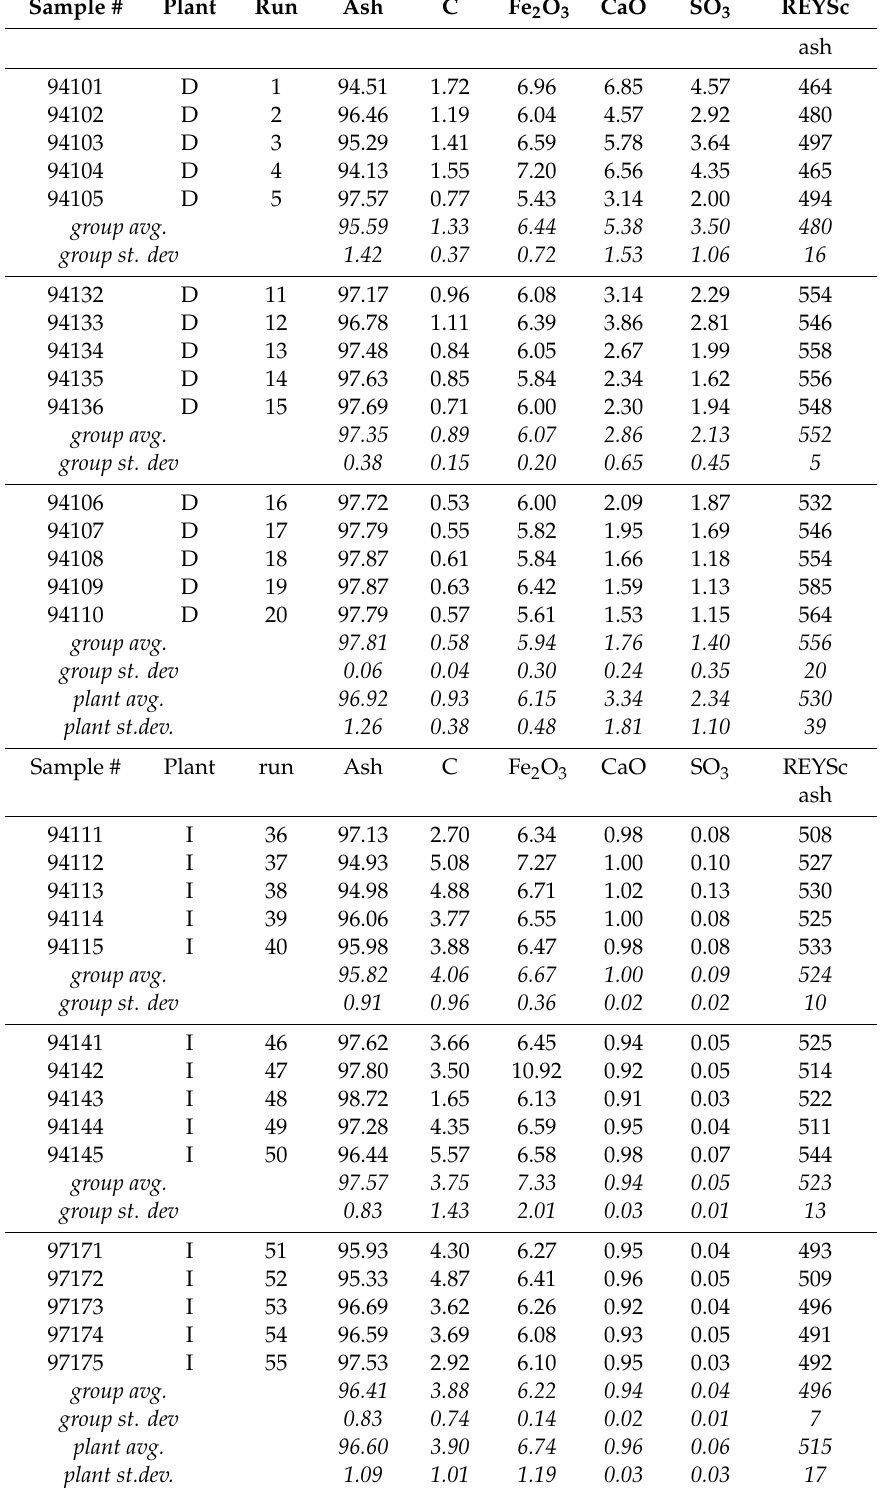
Table 3. Selected runs and parameters (C, CaO, SO 3 , Fe 2 O 3 , and REE; ash listed, but not part of analysis of variance (AOV)) for analysis of variance